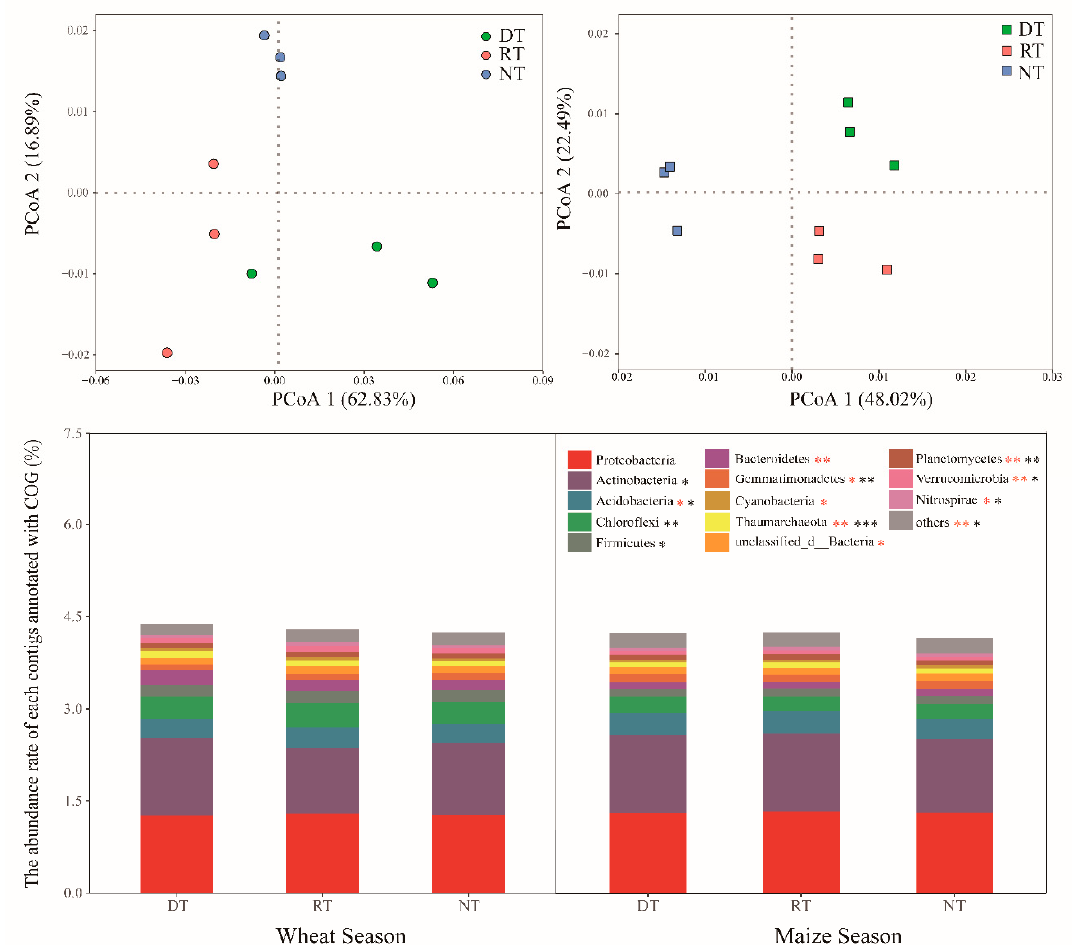
Figure 4. Top : Principal co-ordinate analysis (PCoA) of the microbial community composition relevant to carbohydrate transport and metabolism against clusters of orthologous groups of proteins (COG) genes at the phyla level based on Bray–Curtis distances. Bottom : The relative abundance of dominant bacterial phyla relevant to carbohydrate transport and metabolism genes (focused on the metabolic pathways represented by >1% of all annotated genes); the data are the means ( n = 3) for each treatment. * Indicates a significant difference between treatments at p < 0.05. ** Indicates a significant difference between treatments at p < 0.01. *** Indicates a significant difference between treatments at p < 0.001. Red * and black * indicate the wheat season and the maize season, respectively. Left: wheat season, right: maize season. The same as below.